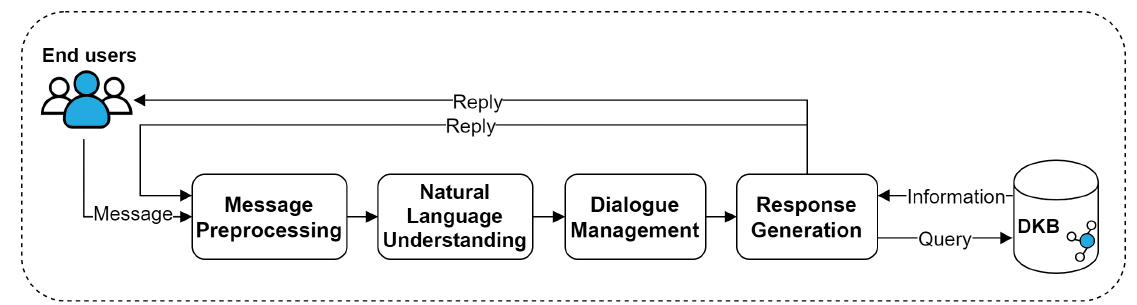
Figure 2. DisBot